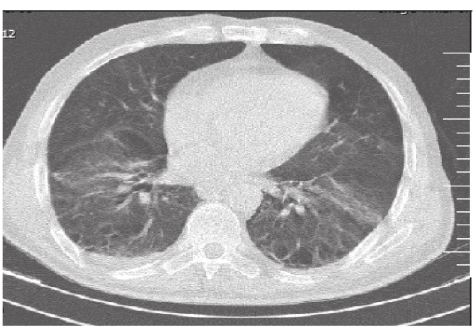
Figure 2: Male patient’s chest CT.